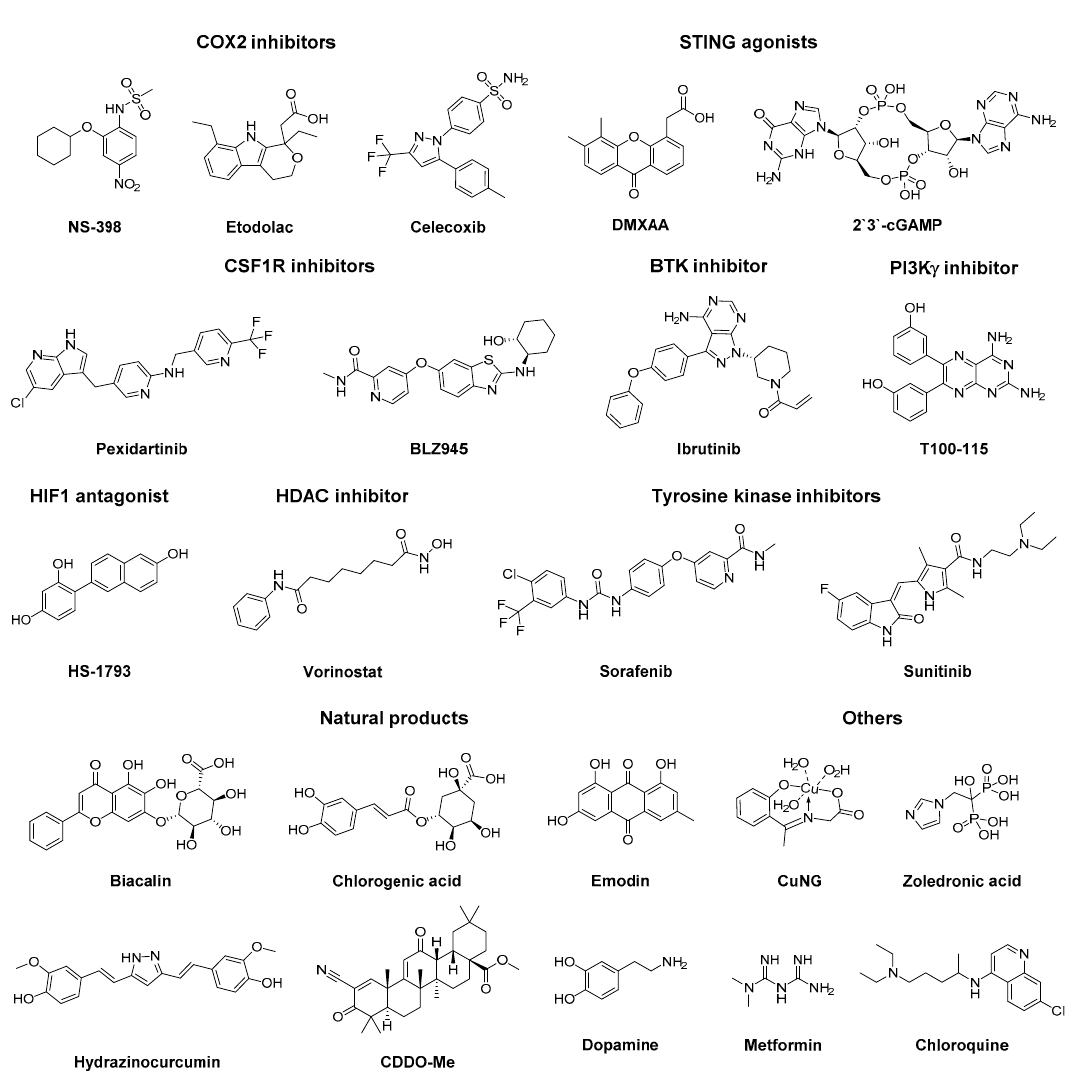
Figure 4. Chemical structure of TAM reprogramming small molecules.